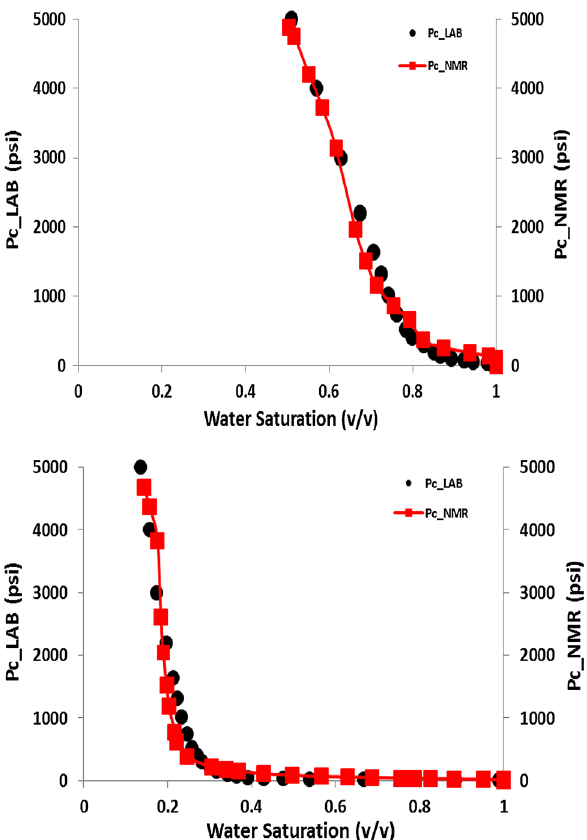
Fig. 23 Calibrated Pc-NMR and Pc-LAB for the mud rich thin bed (top) and inter-channel thin beds (bottom) units indicating a good match in capillary attributes (entry pressures and irreducible water saturation)